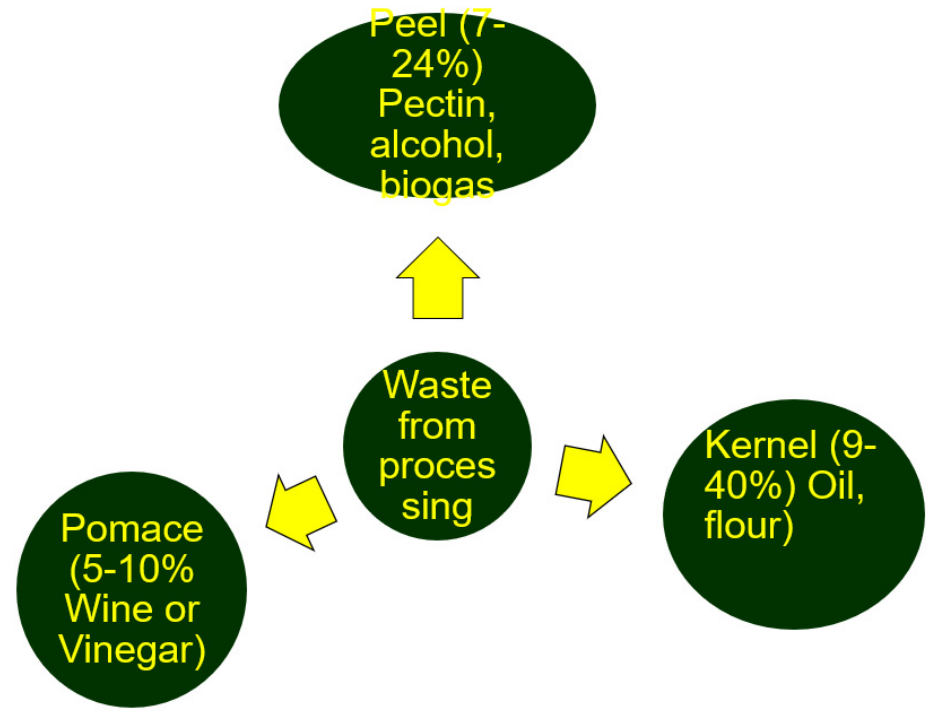
Figure 2. Utilization of mango processing waste.